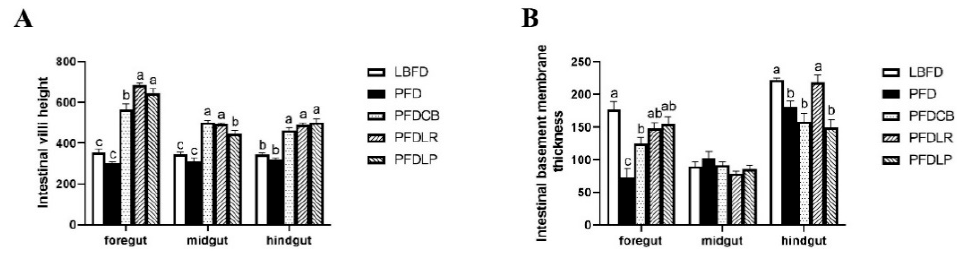
Figure 13. Intestinal villi height ( A ) and basement membrane thickness ( B ) of mandarin fish in dif- ferent feeding groups (LBFD, PFD, PFDCB, PFDLR and PFDLP) after being fed for 28 days. Data are presented as mean ± SEM ( n = 3). Abbreviations: LBFD, live bait fish feeding group; PFD, pellet- feed feeding group with probiotics free; PFDCB, pellet-feed feeding group with C. butyricum plus; PFDLR, pellet-feed feeding group with L. rhamnosus plus; PFDLP, pellet-feed feeding group with L. plantarum plus. A value followed by a lowercase superscript (a-c) differs significantly from all other values not followed by the same lowercase superscript at the same time point based on ANOVA followed by the post hoc test ( p < 0.05).